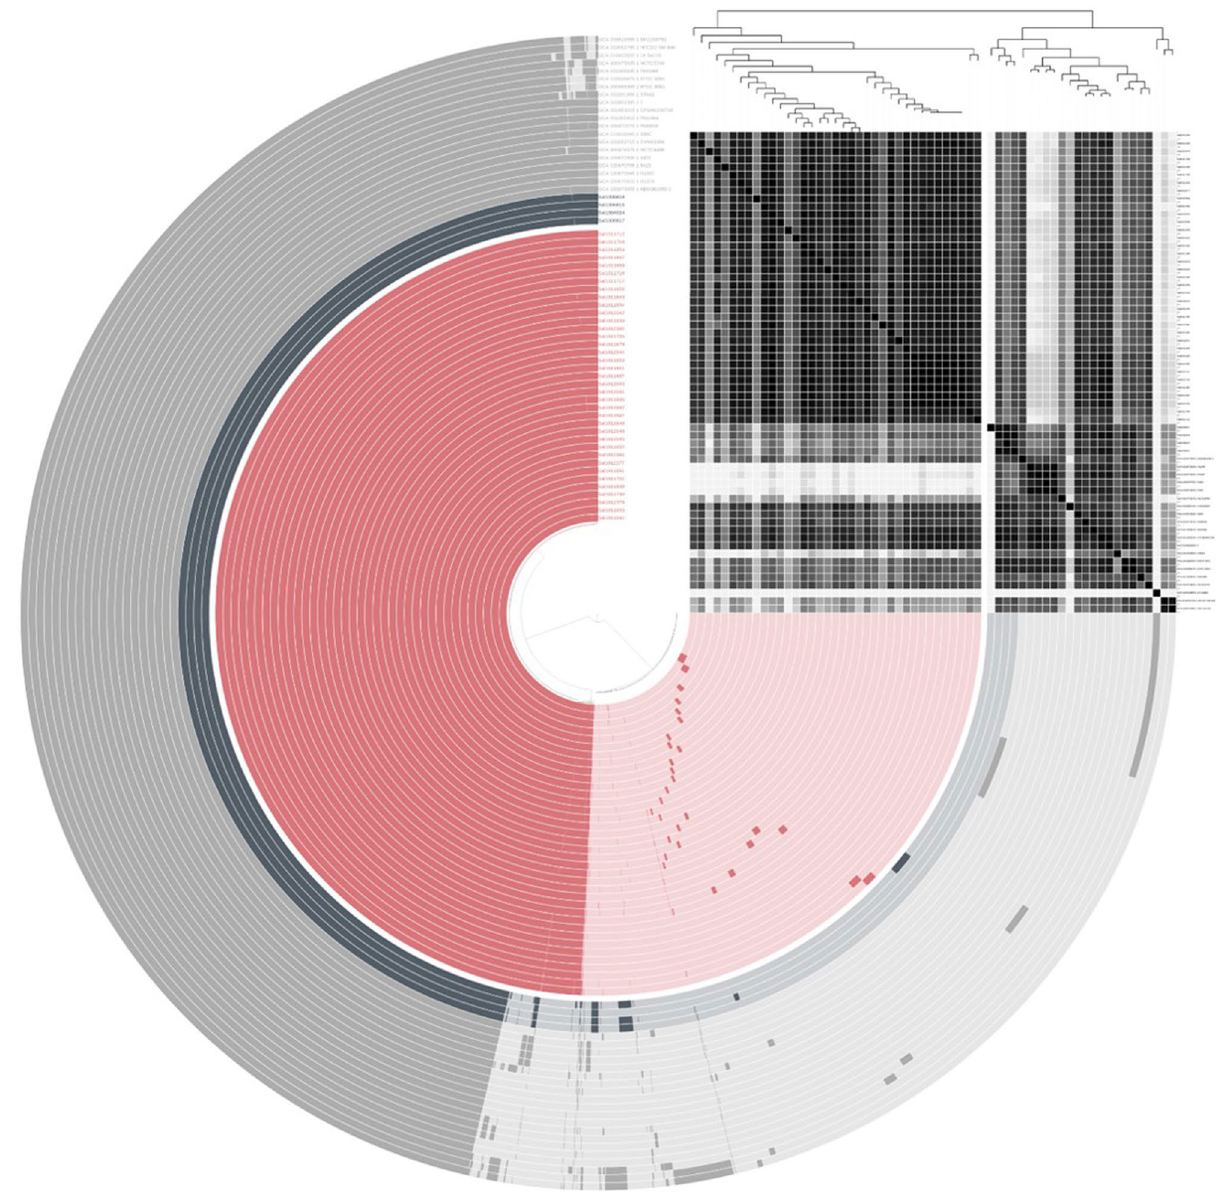
Figure 3. Pan-genome distribution of 61 Salmonella enterica serovar Thompson genomes. The color bar of pink, black, and gray represents chocolate cake S. Thompson outbreak-related genomes, other outbreaks in South Korea, and genomes obtained from the NCBI, respectively. In the layers, the dark and bright colors indicate the presence and absence of genes, respectively. Average nucleotide identity is represented as a heatmap showing high (black) and low (gray) similarity on the upper right region in the figure. Figure was generated using Anvi’o v. 6.0 (https:// anvio.